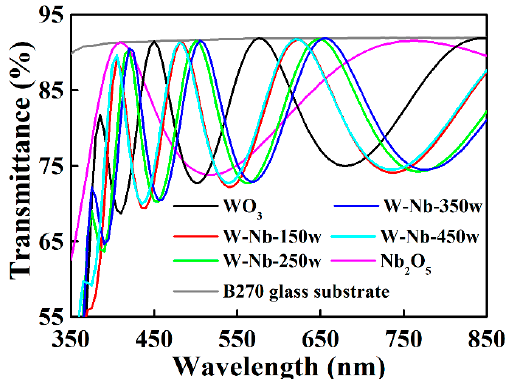
Figure 5. Transmittance spectra of WO 3 , WO 3 –Nb 2 O 5 , and Nb 2 O 5 films coated on B270 glass substrates.